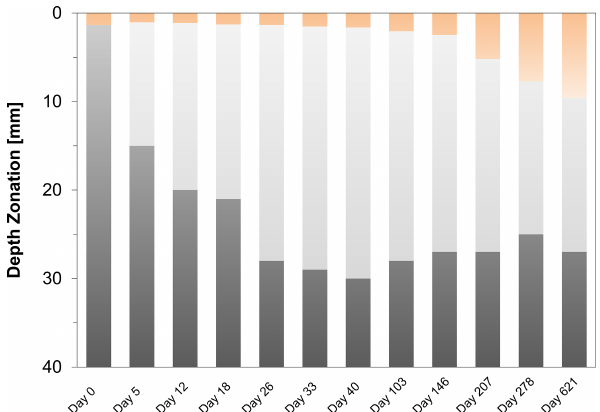
Figure 3. Time series of the development of the oxic zone (orange), suboxic zone (light grey) and the anoxic/sulfidic zone (dark grey) in the sediment. These zones were calculated from three replicate microelectrode depth profiles retrieved from two different cores.